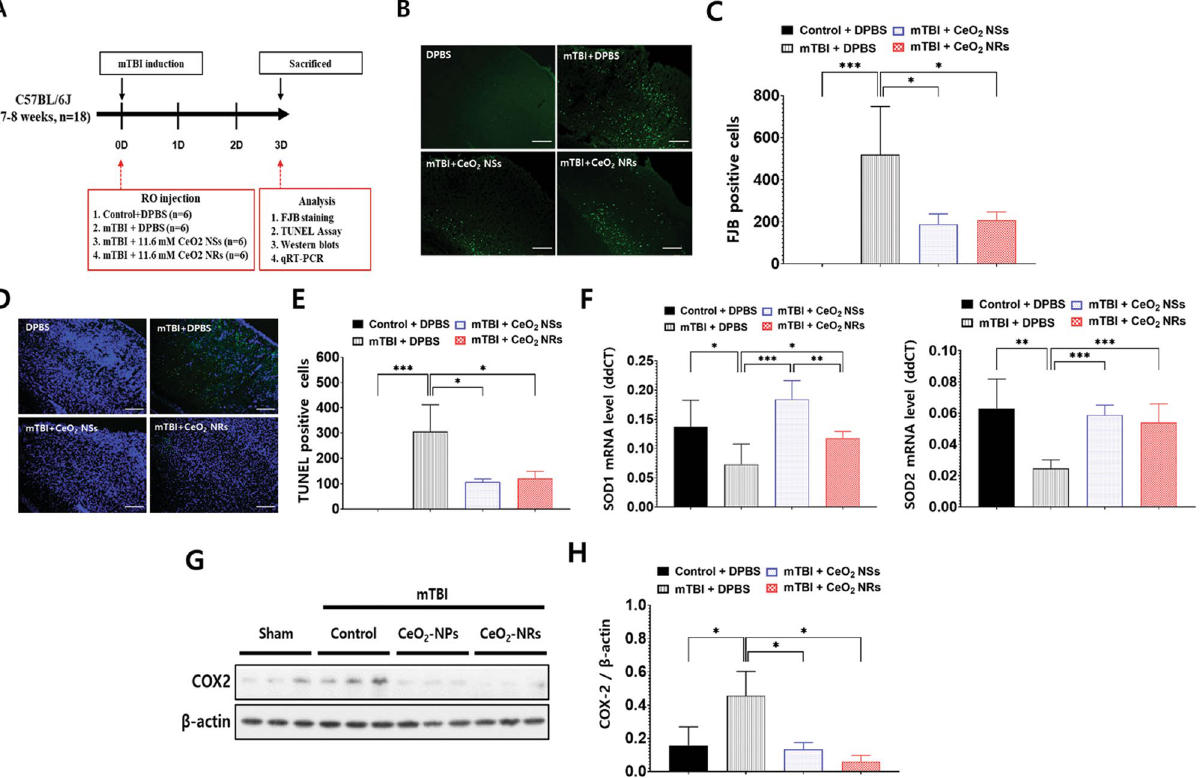
Figure 3. Schematic diagram of in vivo study ( A ). Fluoro-Jade B (FJB) staining was used to detect the neuronal death ( B , C ). Fluorescence images represent the relative degree of neuronal death in the cortex. The number of FJB-positive cells were decreased in Ceria NRs and Ceria NSs than in DBPS group. TUNEL assay in mTBI in vivo ( D , E ). Representative images of TUNEL-positive green cells and its quantification. DAPI was used to counterstaining (blue). The level of SOD1 and SOD2 mRNA expression was analyzed using qRT-PCR ( F ). Western blot analysis of COX-2 expression ( G ) and quantification of blots is based on relative optical densities of COX-2 and β-actin protein ( H ). Scale bar = 200 μm. Error bars, mean SEM, *P < 0.05, ** P < 0.01, and ***P <